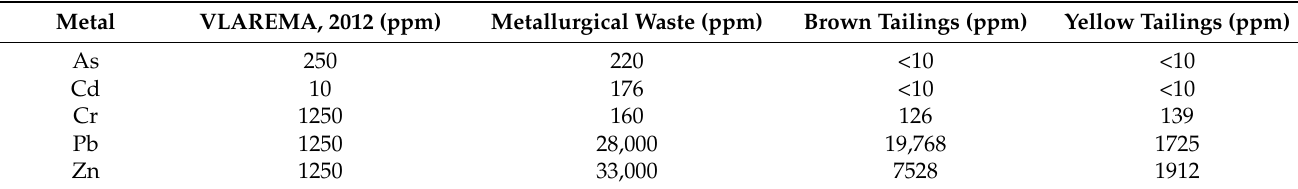
Table 4. Maximum metal and hazardous element contents in the material used for the production of ceramics according to VLAREMA (2012) [70] compared with average values of the metallurgical waste, brown and yellow tailings materials at Plombi è